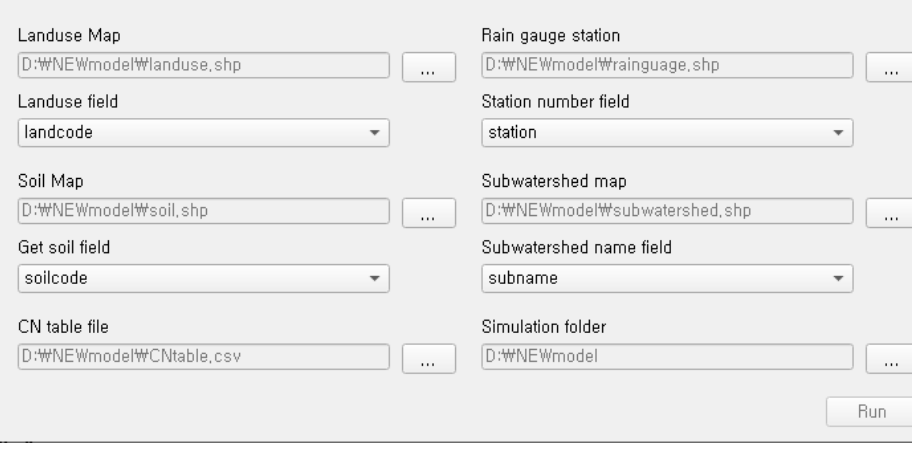
Figure 3. Interface for generating HRU information file.